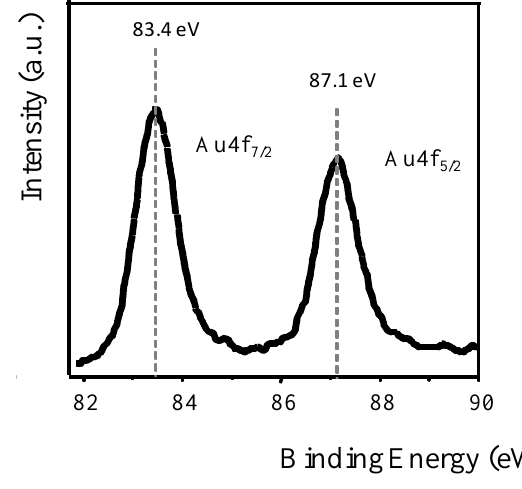
Figure 3. XPS Au4f spectra of Au-decorated CNTs. 3